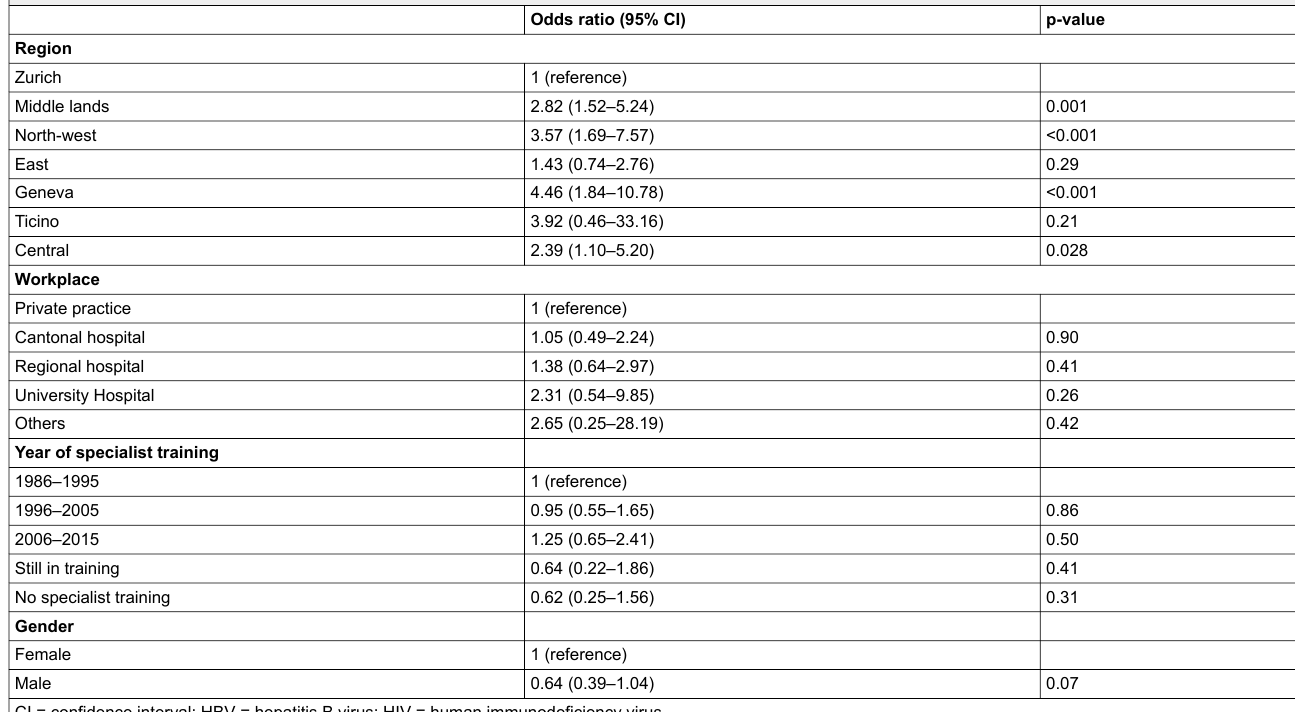
Table S2: Multivariable logistic regression for testing for HIV, HBV and syphilis according to region, clinic characteristics, year of specialist training and gender. Odds ratio (95% CI)